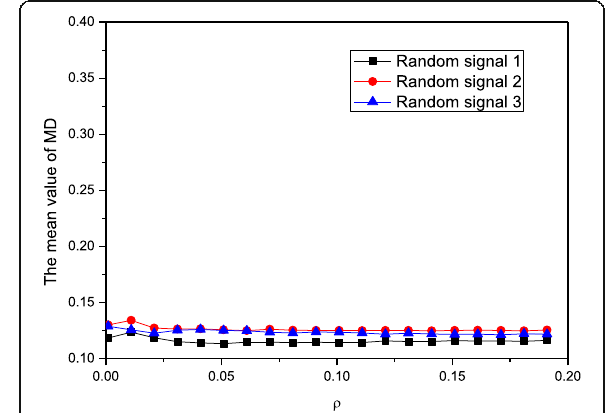
Fig. 7 The MD mean value of three random signals ’ surrogate data. The increase of added noise has no effect on the complexity of random signal, and the curves in the figure remain flat from beginning to